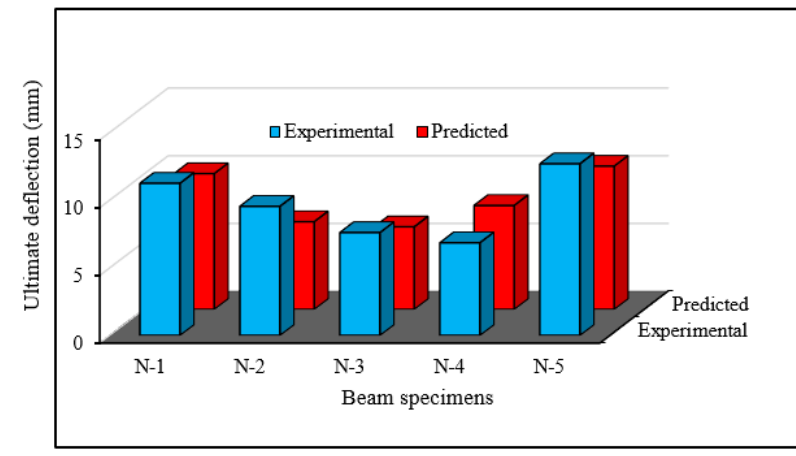
Figure 15. Comparison of experimental and predicted deflection.